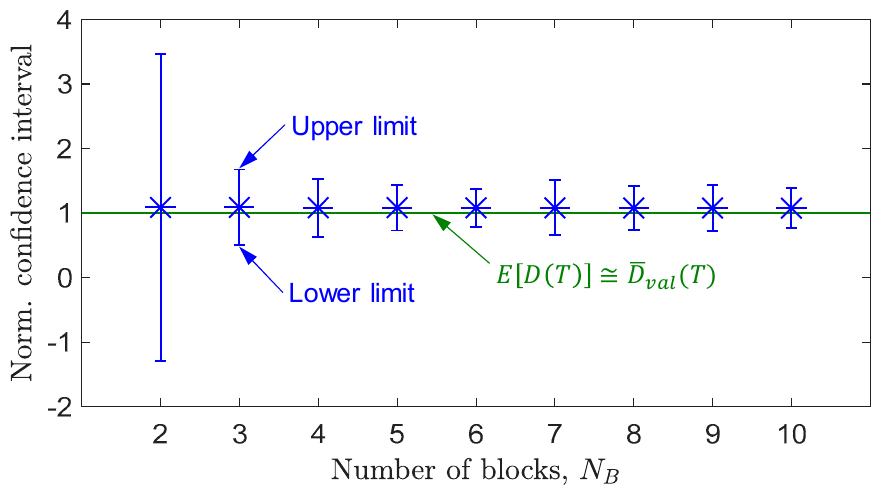
Figure 12. Confidence interval on expected damage for non-stationary switching loading measured in the mountain bike, as a function of the number of blocks.